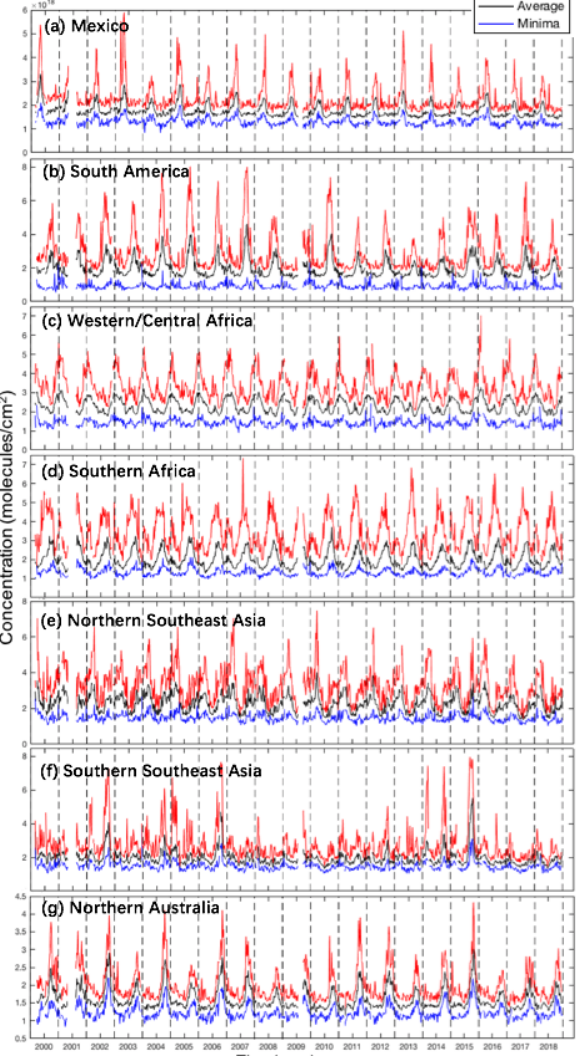
Figure 2 . Time series of MOPITT CO total column the maxima (red curves), average (black curves), and minima (blue curves) over the interest regions.